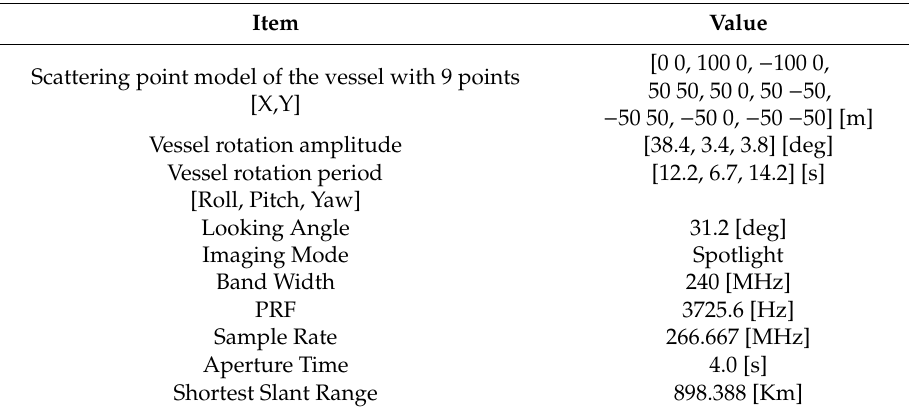
Table 1. Main simulation